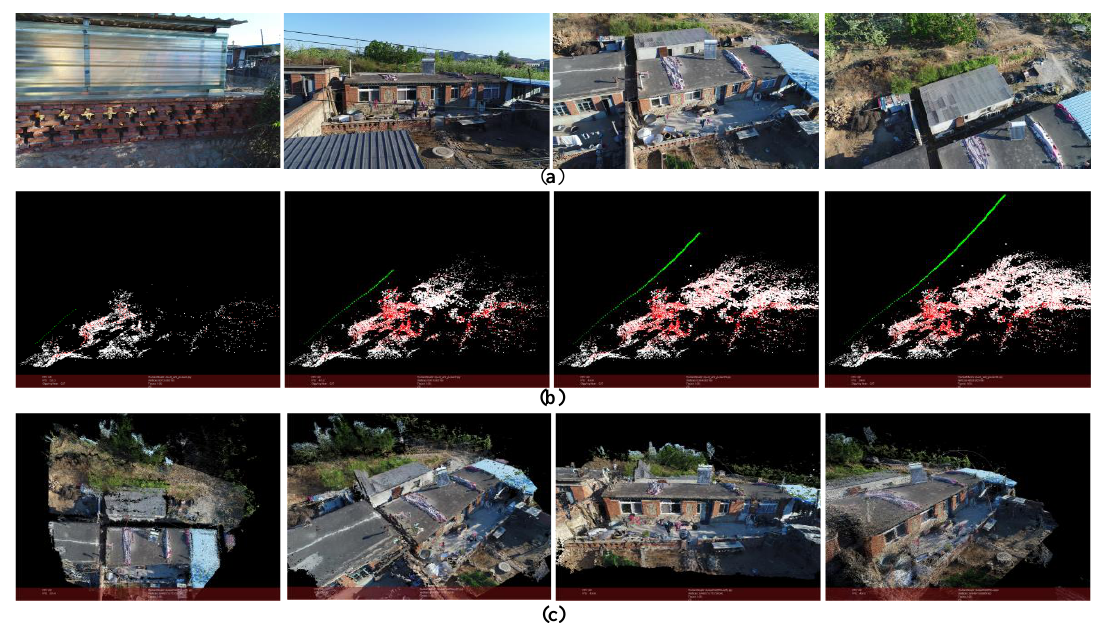
Figure 14. Reconstruction result of a village. ( a ) Part of the images used for reconstruction; ( b ) Structure calculation of image queue SfM (green points represent the positions of the camera); ( c ) Dense point cloud of the scene.